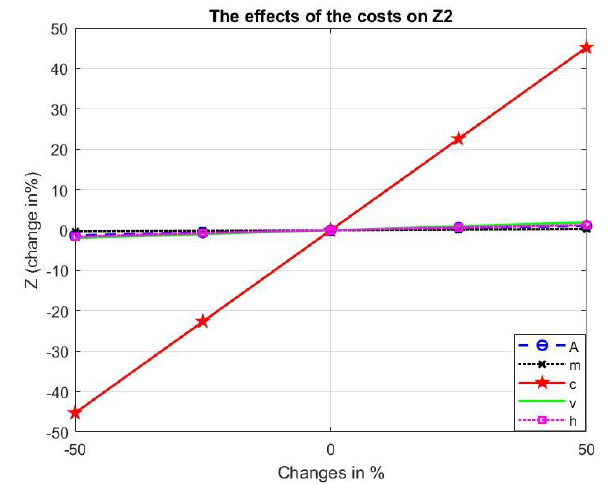
Figure 7. The effects of the cost of the numerical example on the total cost of the second model.